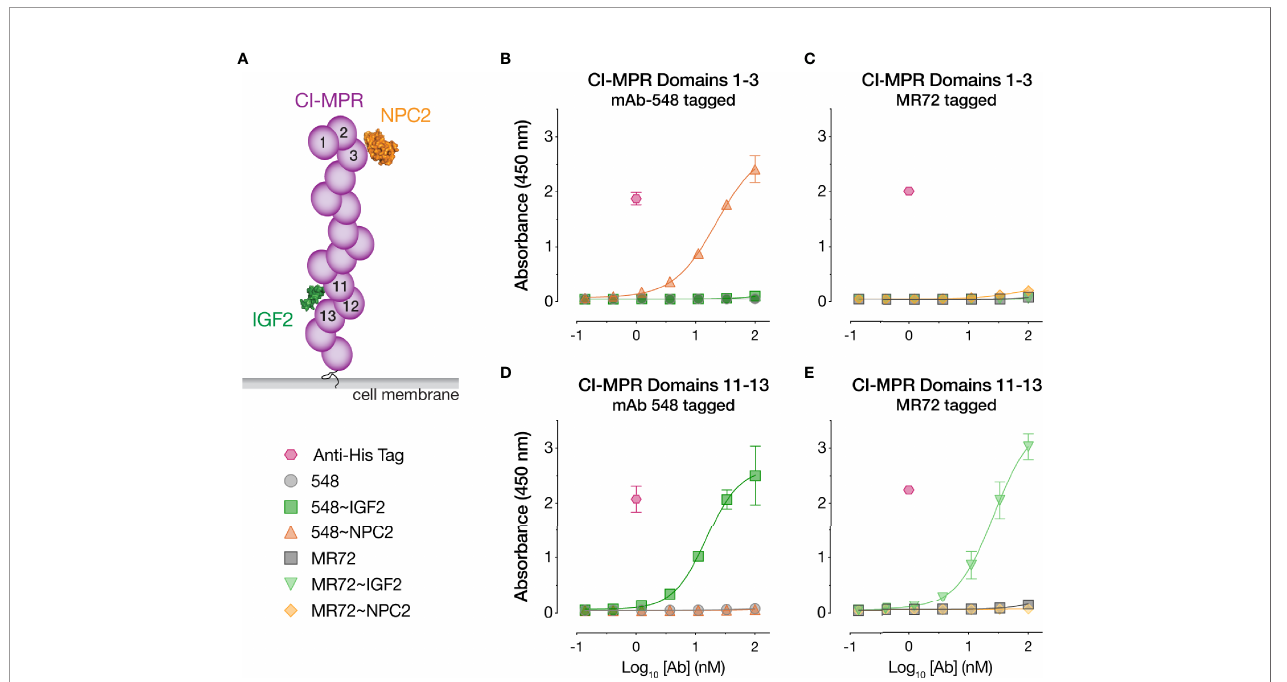
FIGURE 4 | CI-MPR domain binding pro fi les of NPC2- and IGF2-tagged bsAbs. (A) Schematic of CI-MPR recognition by NPC2 and IGF2. (B, C) ELISA reactivity of the indicated bsAbs and parental mAbs against CI-MPR domains 1 – 3. (D, E) ELISA reactivity of the indicated bsAbs and parental mAbs against CI-MPR domains 11 – 13. Means ± SD are shown for 6 replicates from 2 independent experiments.